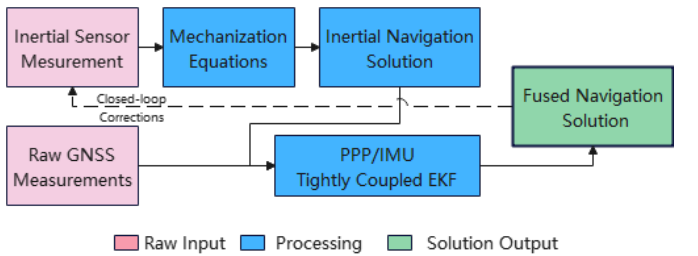
Figure 1. Schematic of the tightly-coupled Extended Kalman Filter in York-PPP user processing engine.